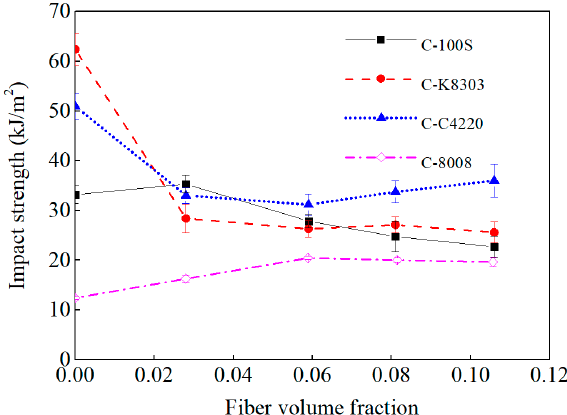
Figure 3. The notched impact strengths of the neat polymers and LFT composites.